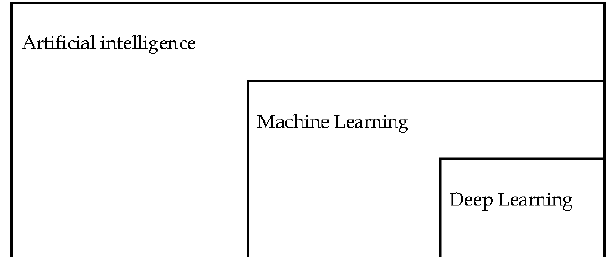
Figure 1. A diagrammatic representation in an attempt to reflect the overlapping domains and relationship of the fields of artificial intelligence, machine learning and deep learning.